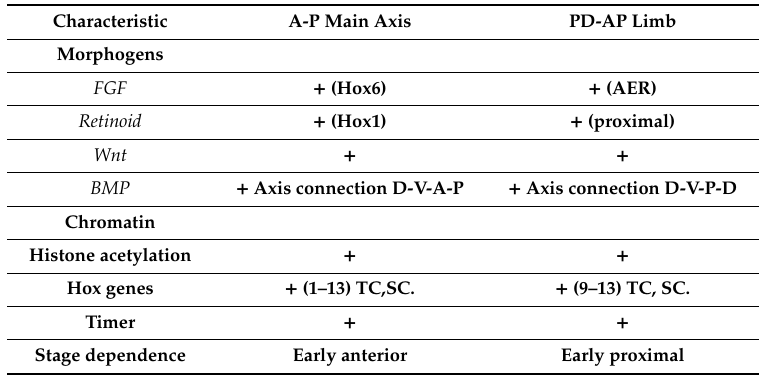
Table 1. Common features, between main body A-P axis and limb P-D axis